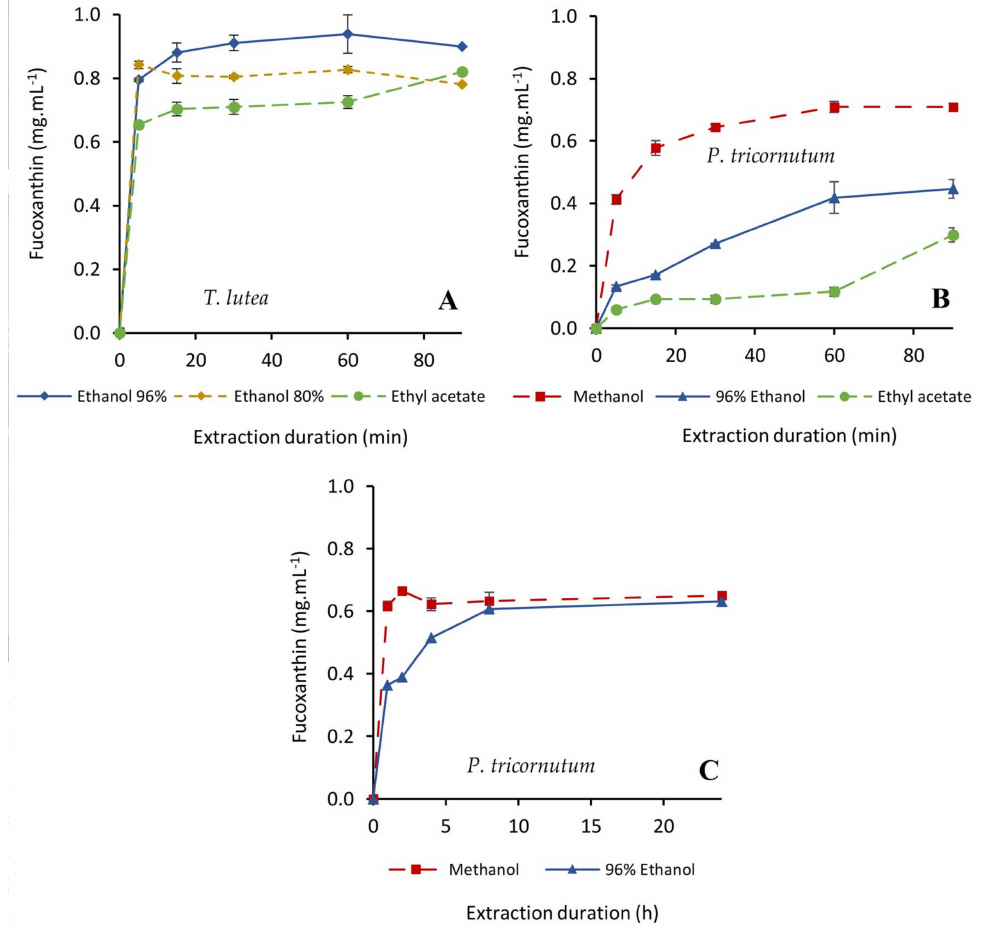
Figure 1. Kinetics of fucoxanthin extraction from freeze-dried Tisochrysis lutea and Phaeodactylum tricornutum with ethanol (80 or 96%), methanol (100%) and ethyl acetate (100%). Extractions were carried out for 90 min at 30 ◦ C ( A , B ) and for 24 h at 40 ◦ C ( C ) with a 20:1 solvent/biomass ratio ( v / w ) in a closed system with magnetic stirring ( n = 3